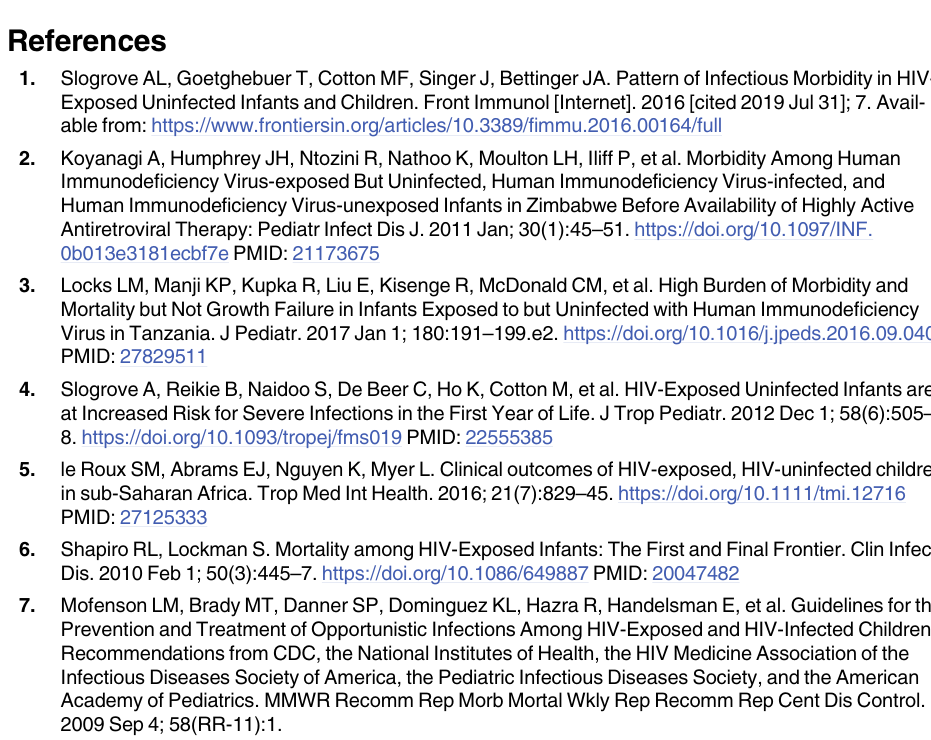
S2 Fig. Cumulative probability of clinical event during